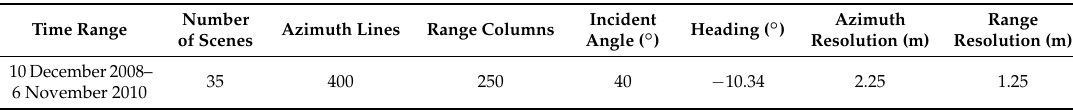
Figure 1. Lupu Bridge: ( a ) side view; ( b ) top view (red circle surrounding the bridge) (Cr. Baidu). Table 1. Parameters of the ascending Cosmo-SkyMed images.